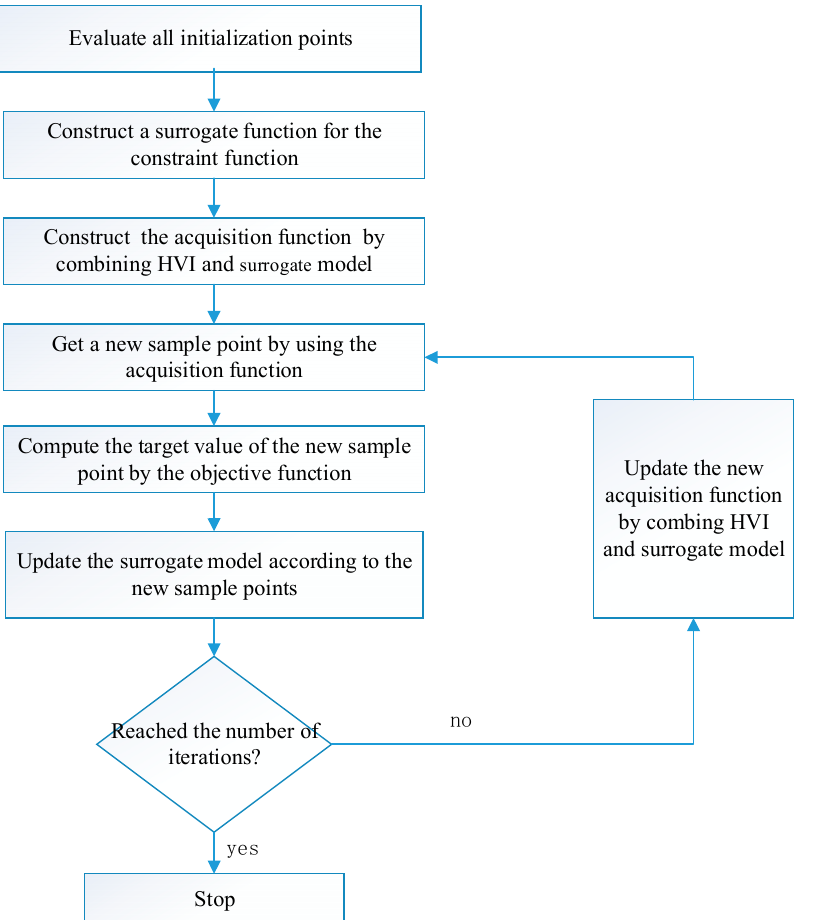
Figure 1. Flowchart of the constrained Bayesian optimization algorithm.